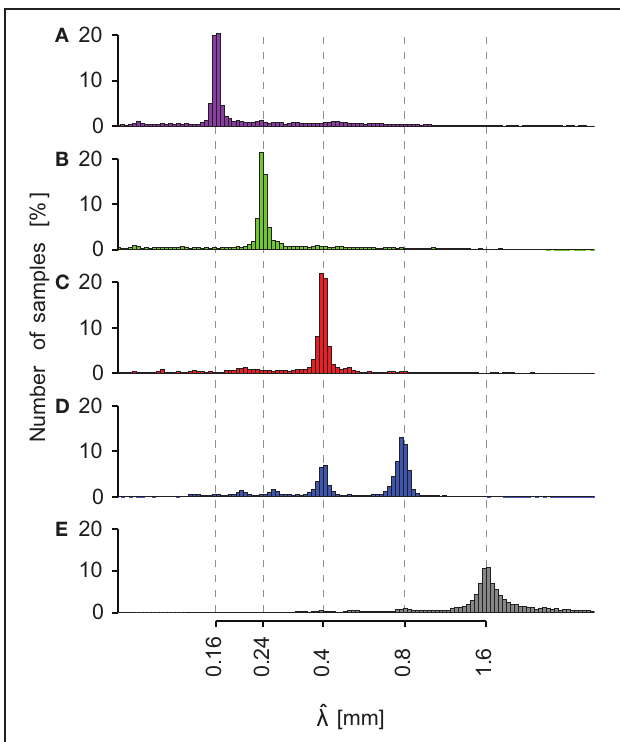
FIGURE 6 | Periodic stimuli: histogram of ˆ λ pooled for all subjects. Each sub-axis corresponds to a different periodic stimulus. (A) λ = 0 . 16mm (magenta). (B) λ = 0 . 24mm (green). (C) λ = 0 . 4mm (red). (D) λ = 0 . 8mm (blue). (E) λ = 1 . 6mm (gray). Dashed lines represent the actual spatial period of the stimuli. For each periodic grating, the principal mode corresponds to the theoretical value. The x-axis has a logarithmic scale. Logarithm bin width equals 0.015.